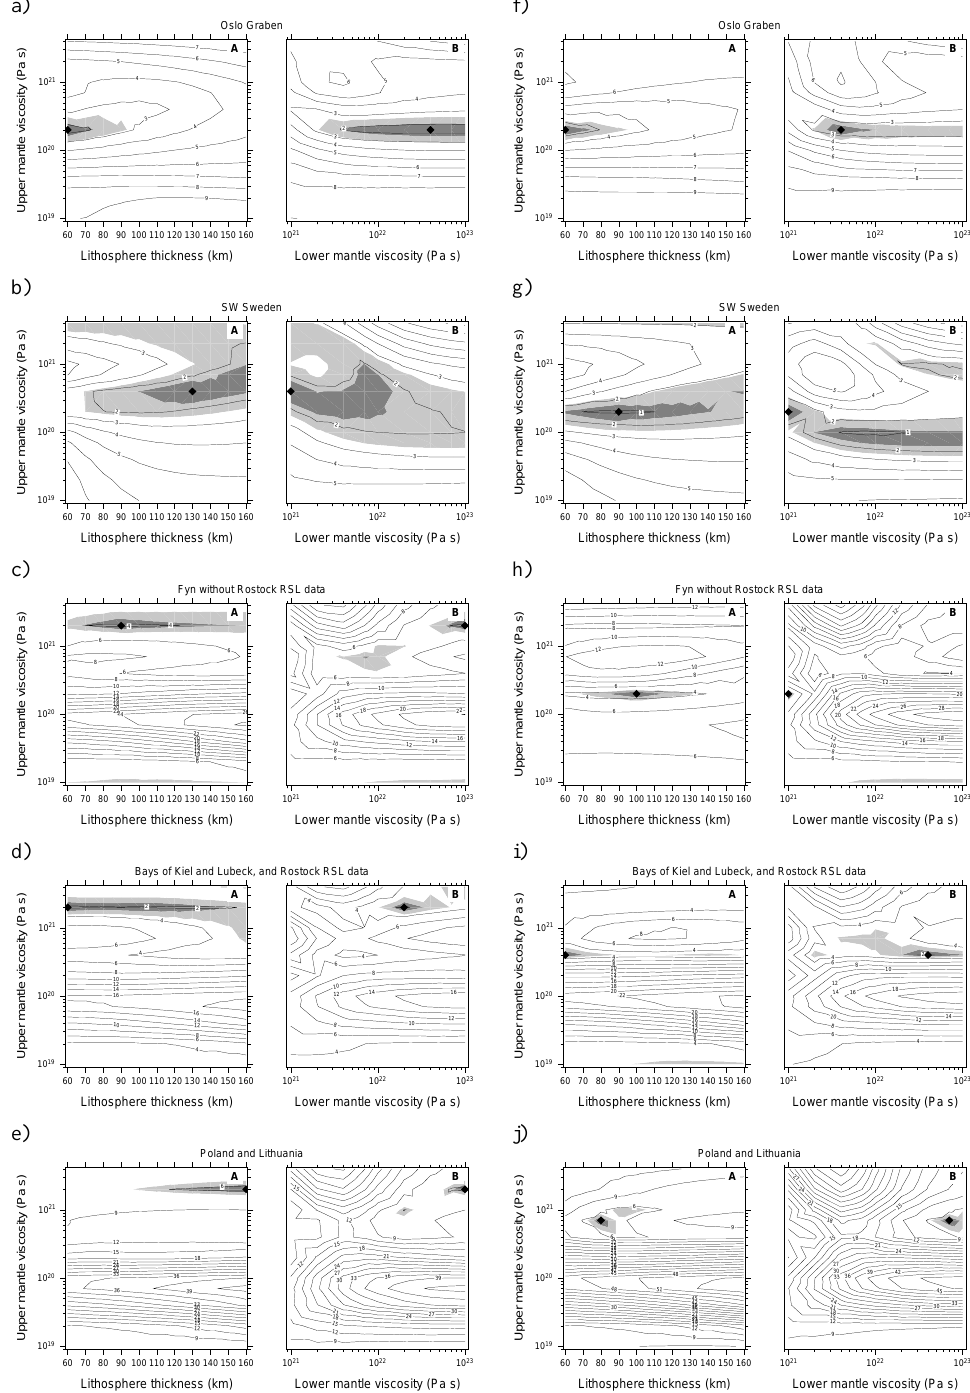
Figure 3. Misfit for ice models RSES (a–e) and ICE-5G (f–j) , three-layer earth model and different data sets. Panel A: the misfit map as a function of lithospheric thickness and upper-mantle viscosity for a fixed lower-mantle viscosity according to the best-fitting earth model, see Table 1. Panel B: the misfit map as a function of upper- and lower-mantle viscosities according to the best-fitting earth model for a fixed lithospheric thickness, see Table 1. (a, f) Misfit map for Oslo Graben RSL data (light and dark green dots in Fig. 1). (b, g) Misfit map for SW Sweden RSL data (red dots in Fig. 1). (c, h) Misfit map for Fyn without Rostock RSL data (violet, dark and light blue dots in Fig. 1). (d, i) Misfit map for bays of Kiel and Lübeck and Rostock RSL data (orange and yellow dots in Fig. 1). (e, j) Misfit map for Polish and Lithuanian RSL data (black dots in Fig. 1). The best three-layer earth model is marked with a diamond, the light and dark shadings indicate the confidence regions ψ ≤ 1 and 1 < ψ ≤ 2, respectively.